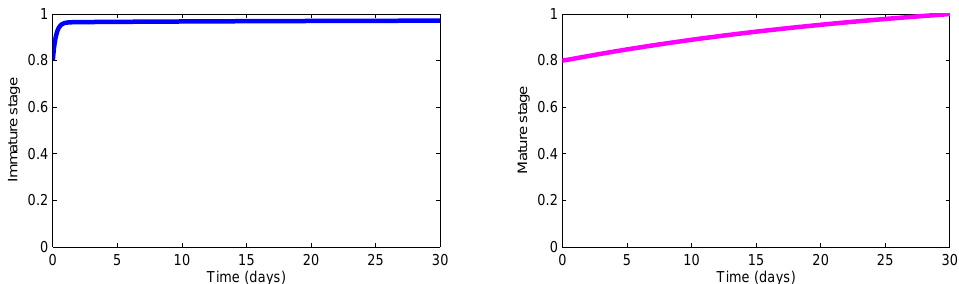
Figure 3. Mosquito population dynamics m q ( t ) ( left chart ) and m a ( t ) ( right chart ) without control intervention (Strategy 000, baseline